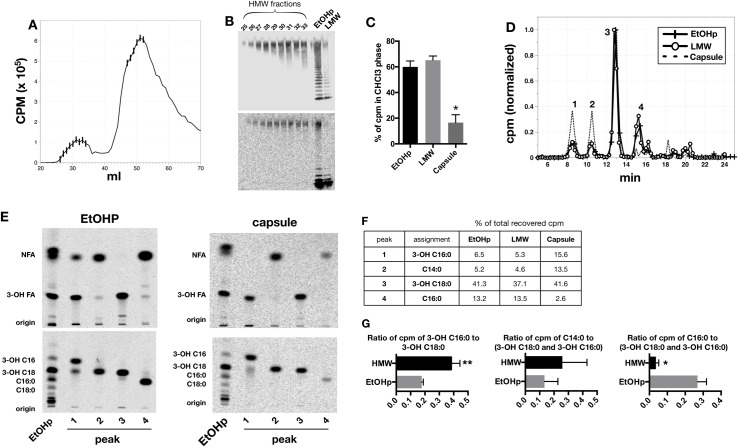
Fatty acid analysis of HMW O-Ag capsule.A) Elution of [14C] labeled species during deoxycholate/Sephacryl S-200 chromatography of radiolabeled EtOHp (larger sample input). B) SDS-PAGE followed by immunoblot (O-Ag; FB11, top pane) and autoradiogram (bottom pane) representing capsule- and LMW-rich species (fractions 25–33 and 46–51, respectively). C) Percent of cpm of the indicated samples recovered in the CHCl3 phase after chemical hydrolysis and Bligh-Dyer extraction are indicated. * denotes that recovery from capsule is significantly lower than that from both EtOHp and LMW samples, per Tukey’s test for multiple comparisons (P < 0.001). D) HPLC profile of recovered [14C] species in CHCl3 phase from EtOHp, nearly O-Ag-free LMW species, and HMW O-Ag capsule. Each curve was normalized so that the peak of the most abundant species (peak 3) was set at 1.0. E) Normal-phase TLC (top panels) and reverse-phase TLC (bottom panels) of the 4 major peaks derived from EtOHp (left) and capsule (right). Francisella-derived and purified commercial FFA were used to identify individual fatty acids, as indicated. NFA, non-hydroxylated fatty acids. 3-OH FA, 3-OH fatty acids. Note that C14:0 and 3-0H-18:0 (peaks 2 and 3) closely migrate on reverse-phase TLC but are readily distinguished by normal phase TLC. F) Relative content of the 4 major FA substituents of the EtOHp, LMW, and capsule samples, expressed as percent of total cpm recovered. These results represent analyses of fractions derived from the same population of metabolically labeled bacteria. G) Similar analyses were performed on three separate EtOHp and capsule preparations from independent batches of labeled bacteria to demonstrate that FA compositional differences between the EtOHp (in which free lipid A is most abundant) and HMW O-Ag capsule are reproducible and, where indicated (*, P < 0.05 and ** P < 0.001 for paired T tests) significant. Left panel: ratio of [14C] 3-OH-16:0 to [14C] 3-OH-18:0; center panel: ratio of [14C] C14:0 to combined [14C] 3-OH-16:0 + 3-OH-18:0; right panel ratio of 14[C] C16:0 to combined [14C] 3-OH-16:0 + 3-OH-18:0.